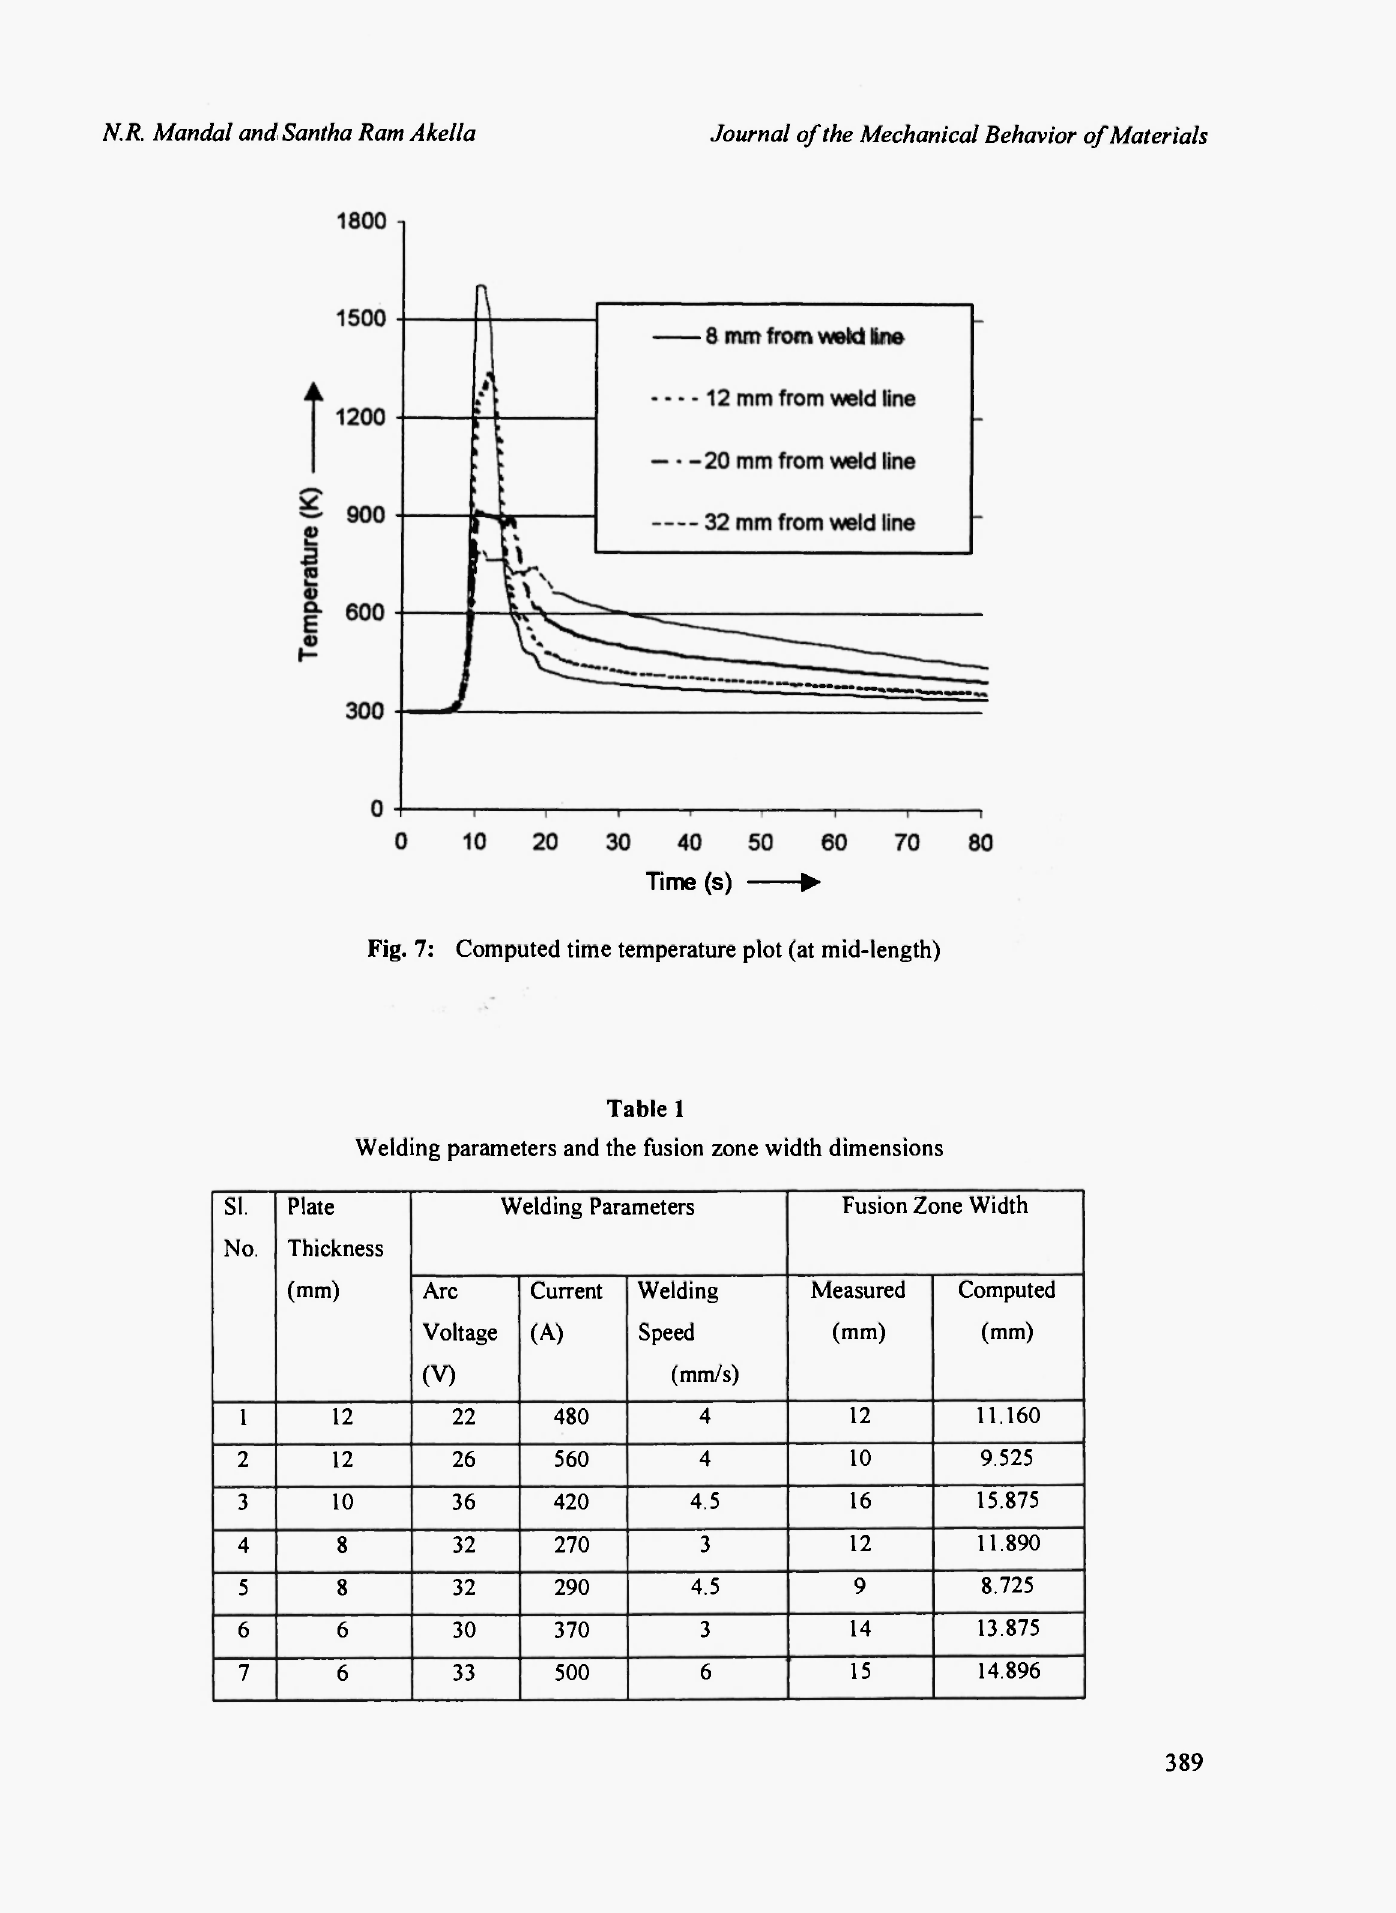
Fig. 7: Computed time temperature plot (at mid-length)